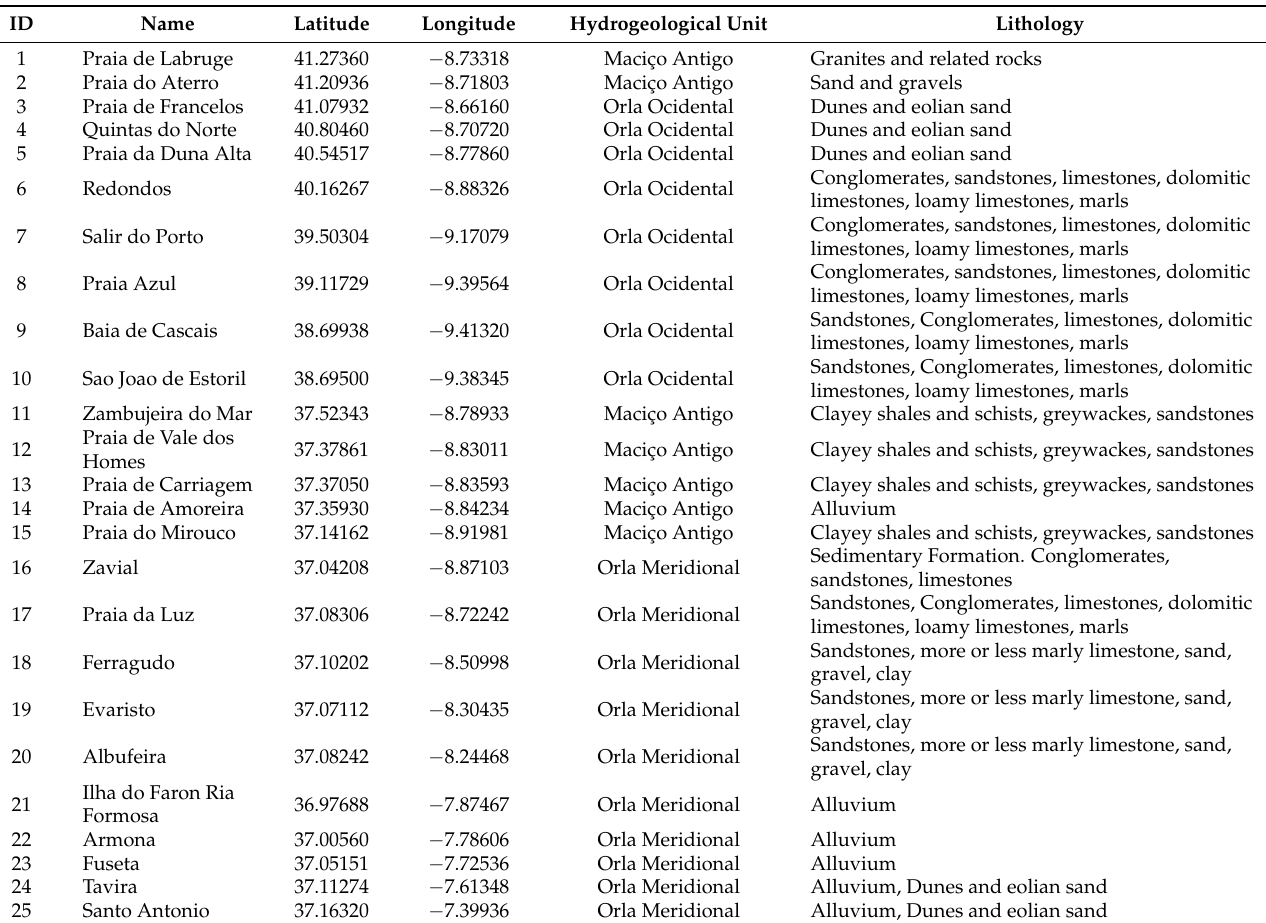
Figure 5. Standardized Temperature Anomaly and Potentiometric Surface for the ( a ) South, ( b ) Southwest, ( c ) Center, ( d ) Northwest, and ( e ) North subregions. In the South region (Figure 5a), the visible potential SGD sites can be associated with Table 3. Description of the cold-water anomalies and potential sites of groundwater the presence of coastal aquifers, like the Covões system in the left corner near Sagres and